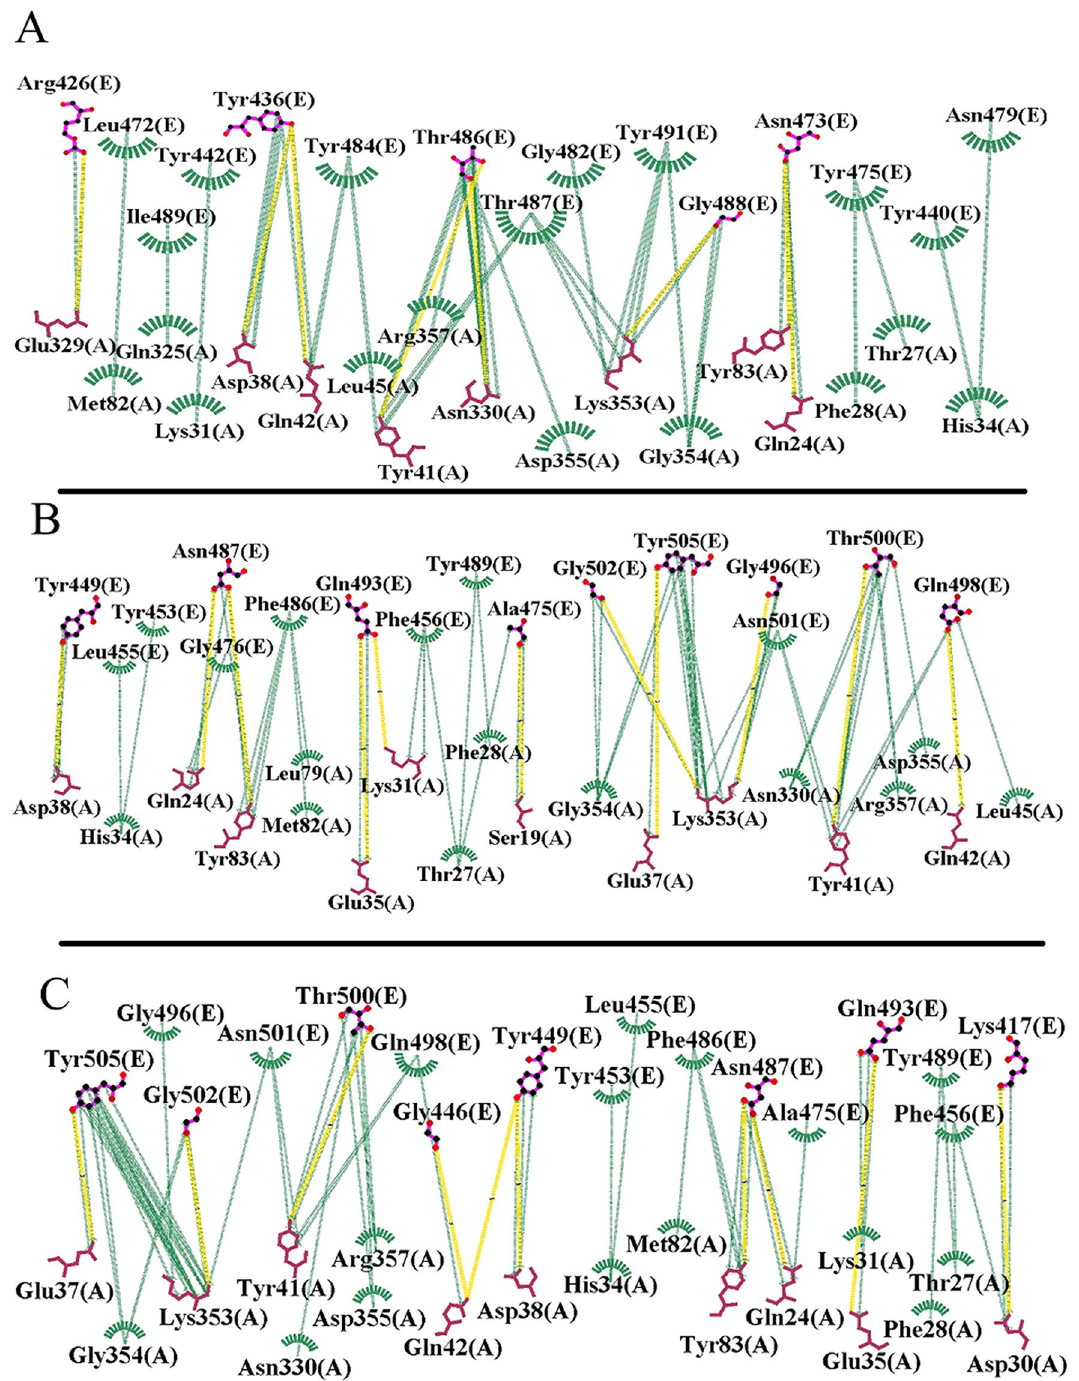
Figure 1. Two-dimensional interaction schemes for the spike-ACE2 complex: SARS-CoV ( A ), chimeric structure ( B ), and SARS-CoV-2 ( C ). ACE2 and spike proteins residues denoted by A and E in parenthesis respectively. Also, hydrogen bonds and hydrophobic interactions are colored in yellow and green lines respectively. The images have been obtained by LigPlot + v.1.4.5 (https:// www. ebi. ac. uk/ thorn ton- srv/ softw are/ LigPl us/) 22